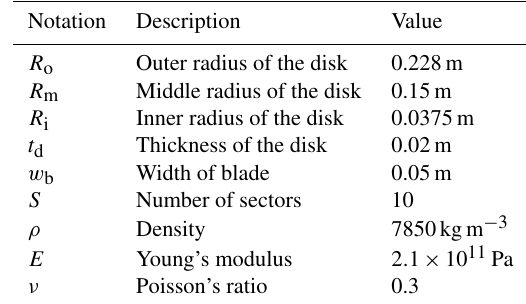
Table 1. Values of the dimension and material parameters of the